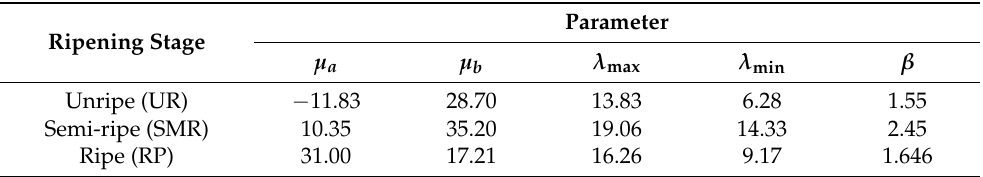
Table 1. Ellipses parameters for ripening stages classification.